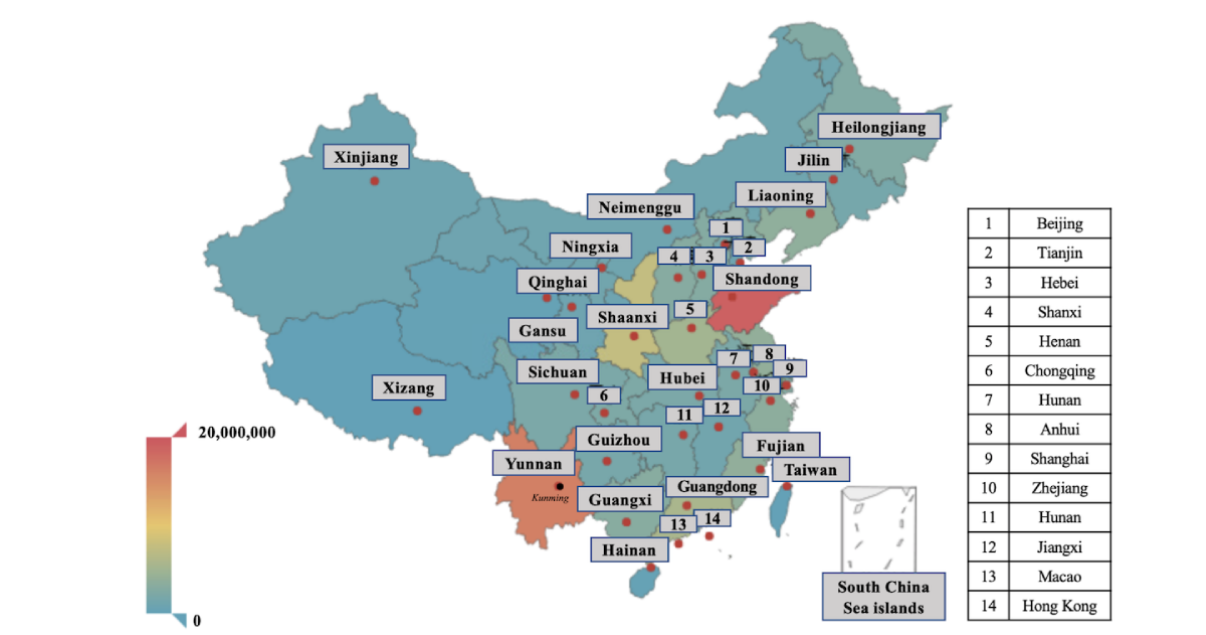
Figure 2. The number of consultations and inquisitions from all over China out of the original 113.8 million data points. Red dots indicate the capital city of each province and the black dot indicates the city of Kunming. Kunming had the largest volume of consultations and inquisitions in Ping An Good Doctor at the city